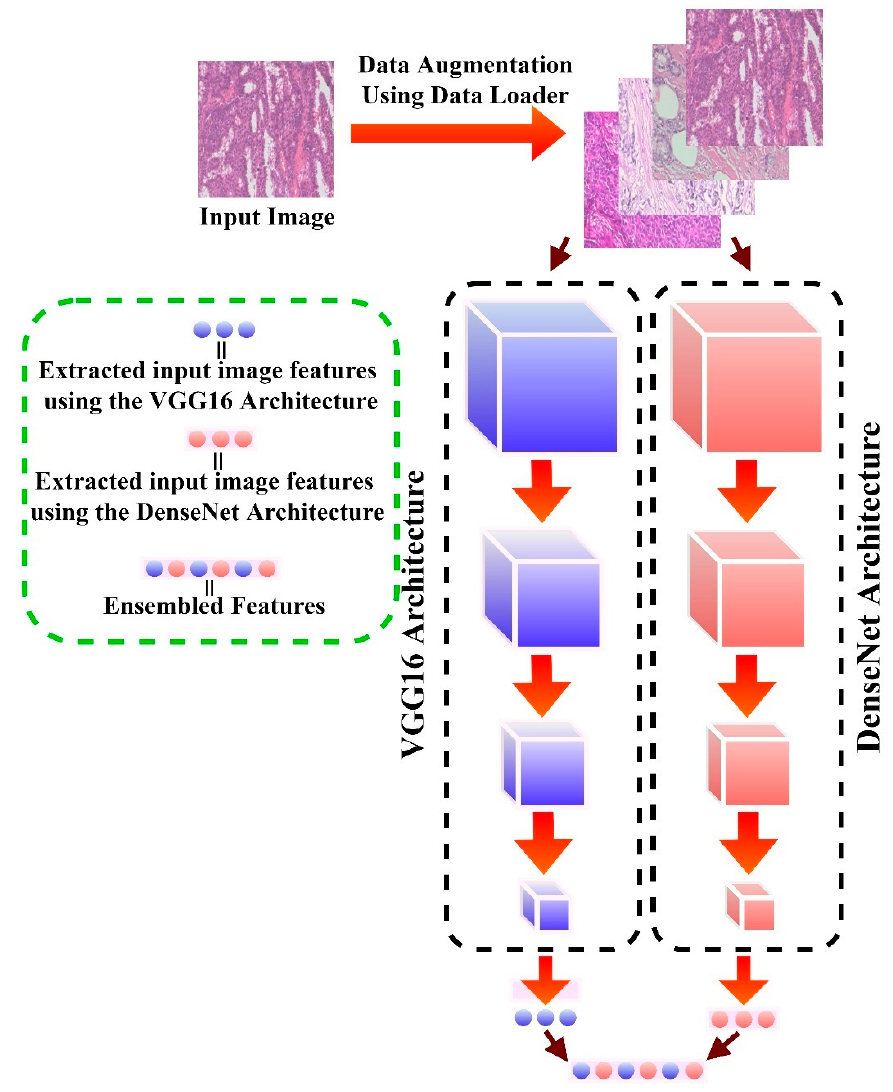
Figure 4. Proposed network backbone architecture. Table 5. Optimal parameters of all implemented